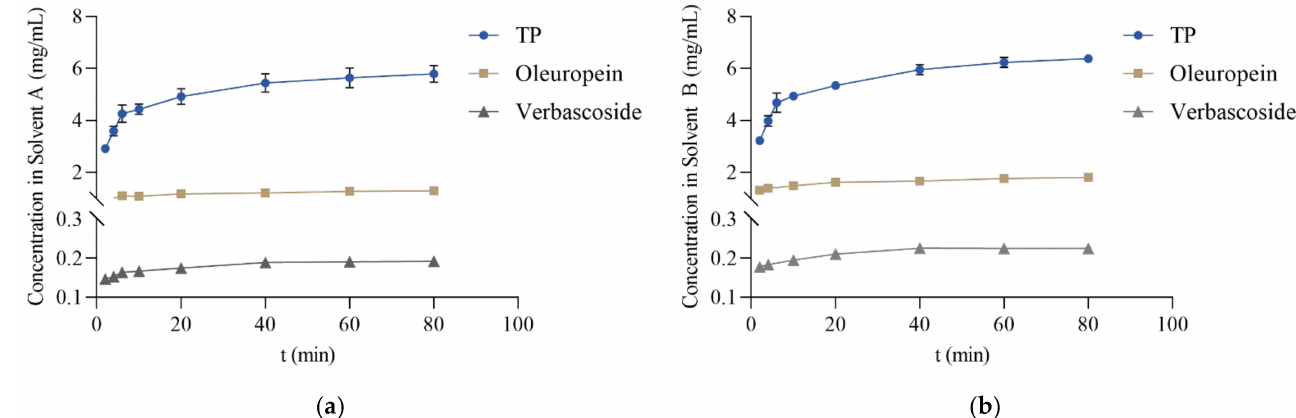
Figure 1. Kinetics plots of total phenolic content (TP), oleuropein, and verbascoside extraction from olive leaf using the solvents ( a ) A and ( b )